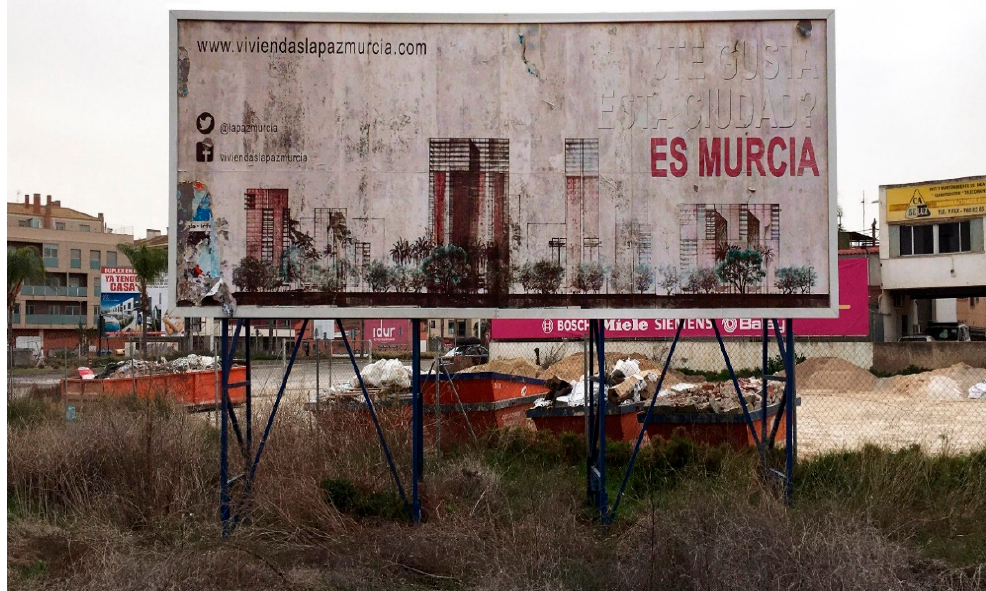
Figure 20. Existing billboard announcing Ricardo Bofill’s controversial project for Barrio de la Paz: “Do you like this city? It’s Murcia” . Photo: Authors, 2021.